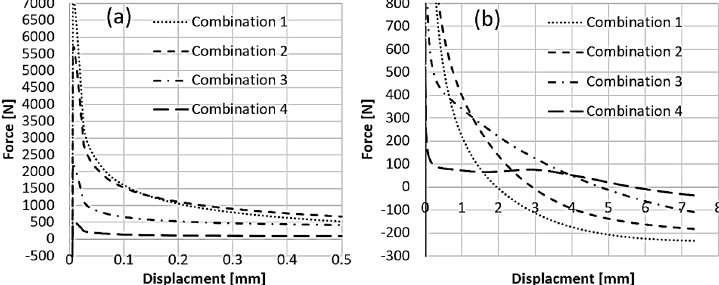
Figure 12. F (d) characteristics obtained with 2275 ampere-turns. The F (d) characteristics are displayed: ( a ) for the initial part of the actuation cycle from 0mm up to 0.5 mm, ( b ) for the rest of the actuation cycle—for the displacements 0.5mm < d < 5 mm.